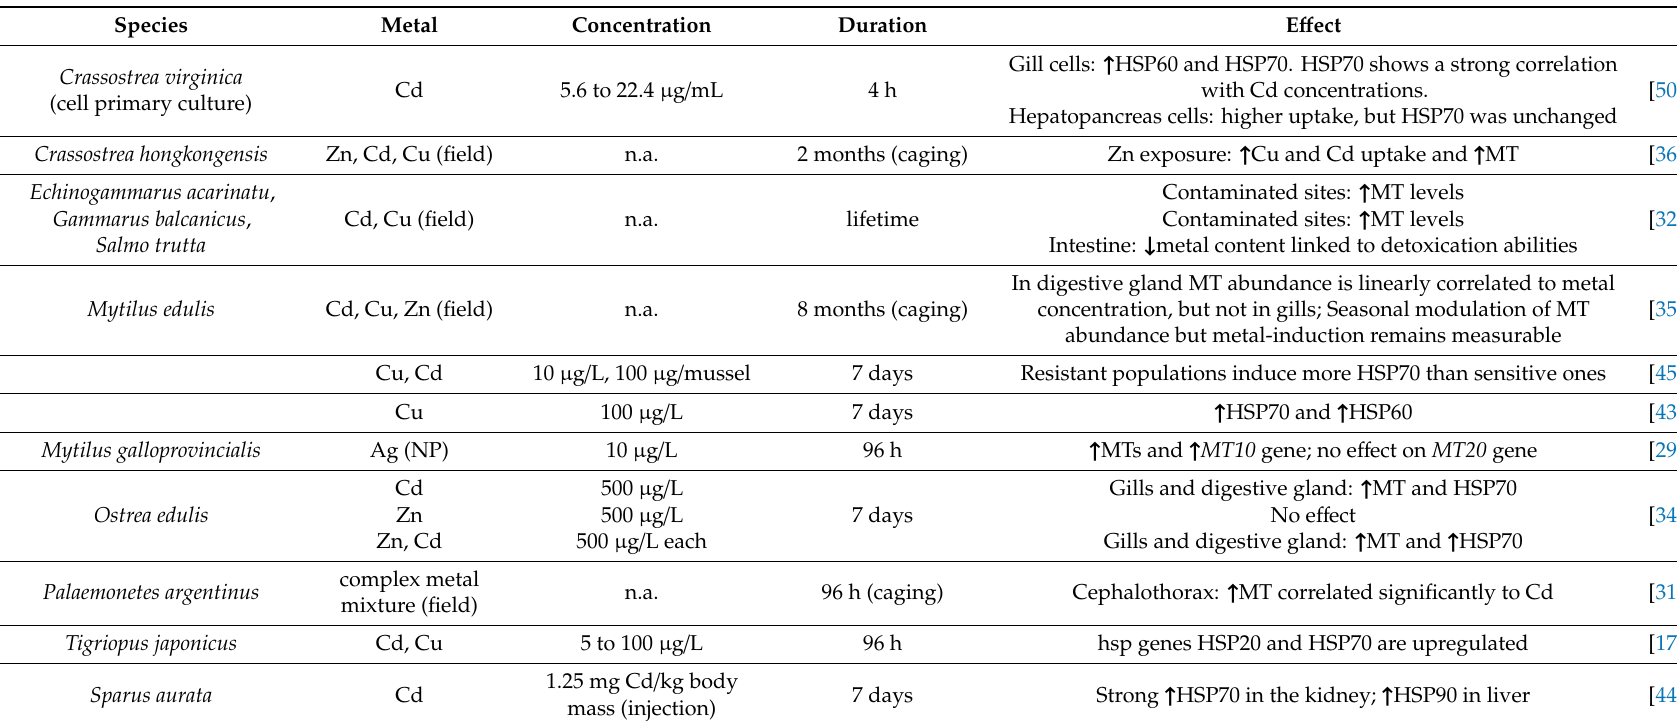
Table 1. Summary of studies describing metal impacts on stress proteins, i.e., metallothioneins (MTs) and Heat Shock Proteins